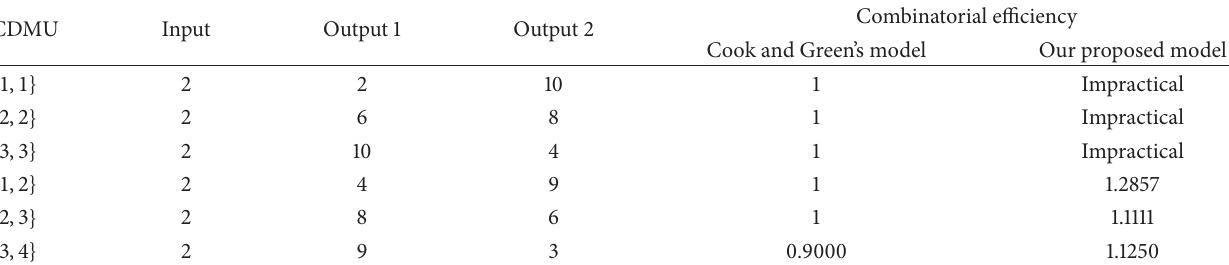
Table 5: Combinatorial efficiency evaluation of Example 1.